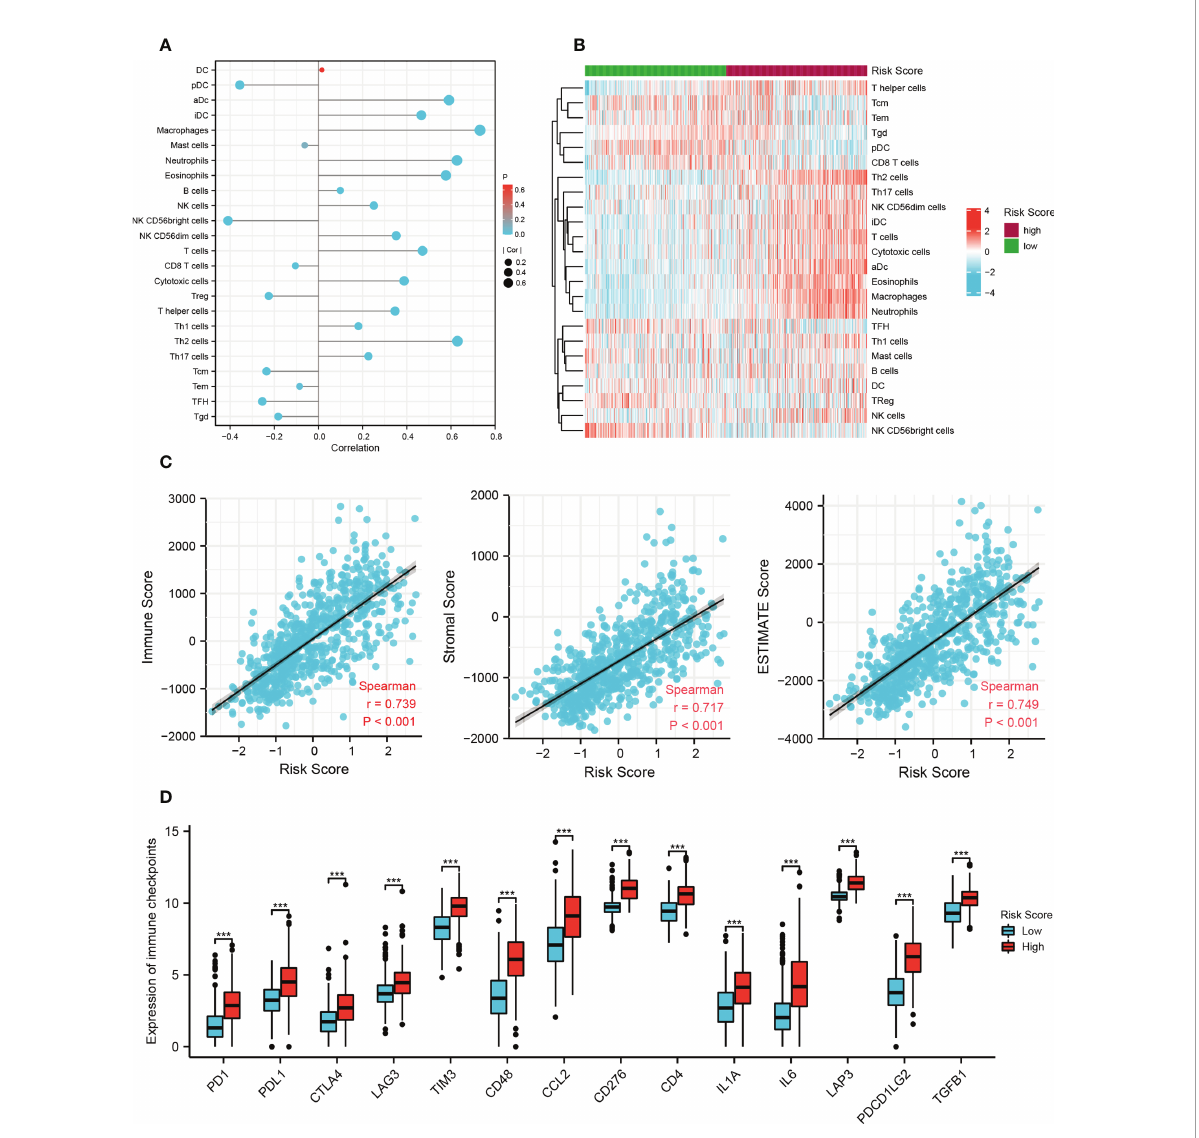
FIGURE 5 Immune-related analysis of the risk model in the TCGA cohort. (A) The correlation between 24 immune cell types and risk score based on the ssGSEA algorithm. DC, dendritic cell; pDC, plasmacytoid dendritic cells; aDC, activated DC; iDC, immature DC; Treg, regulatory T cells; Tcm, T central memory cells; Tem, T effector memory cells; TFH, T follicular helper cells; Tgd, gamma delta T cells. (B) Heat map of ssGSEA scores of 24 immune cell types between the low- and high-risk groups. (C) The correlation between immune scores and risk scores based on the ESTIMATE algorithm. (D) The difference in 14 checkpoint genes expression between the low and high risk groups (*** p <